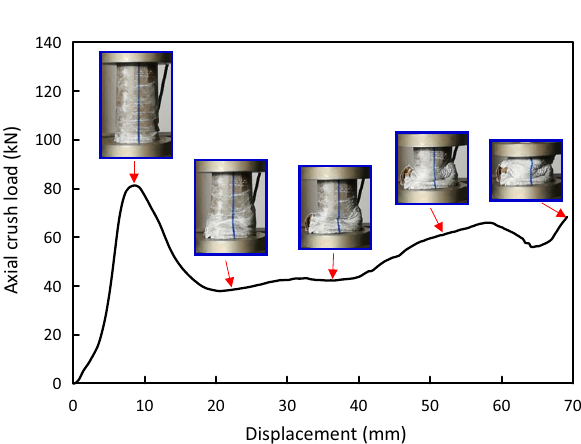
Figure 8. Load–displacement and crushing history for Al/4G/4J test specimen.